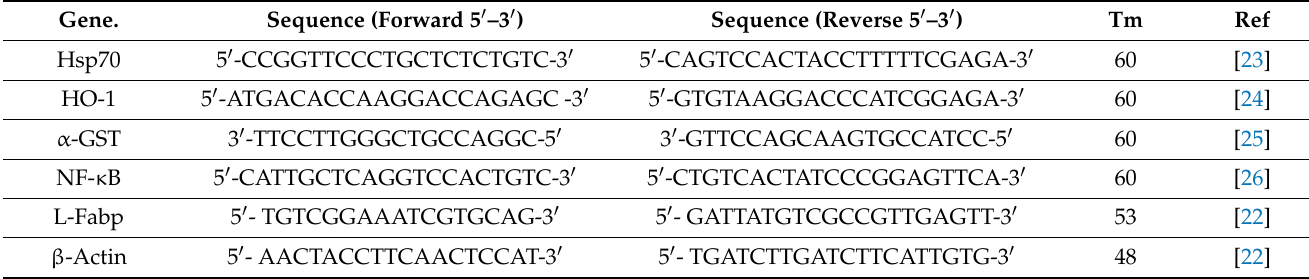
Table 1. Primer sequences and annealing temperatures.